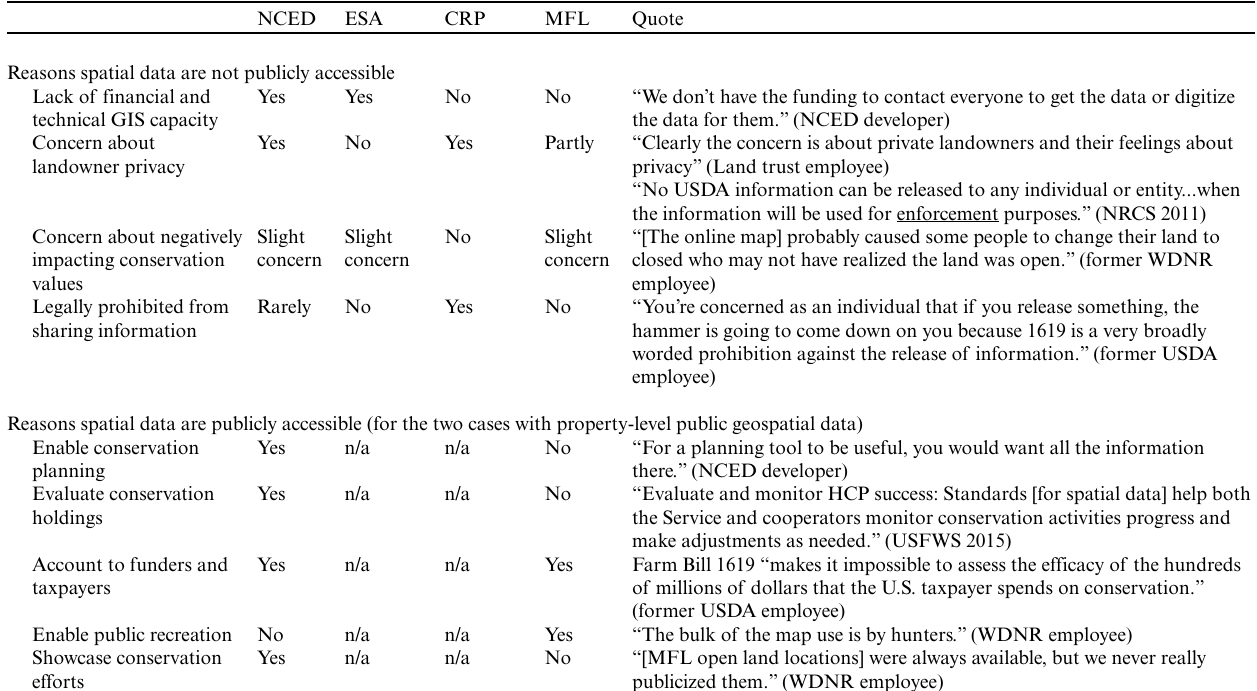
Table 3 . Reasons spatial data are (or are not) publicly accessible in each program, based on document review and interviews. Quotes describe why data are (or are not) publicly accessible and the implications of the current level of information access. Cases are conservation easements in the National Conservation Easement Database (NCED), regulatory mitigation under the Endangered Species Act (ESA), contract payments under the Conservation Reserve Program (CRP), and property-tax incentives under Wisconsin’s Managed Forest Law